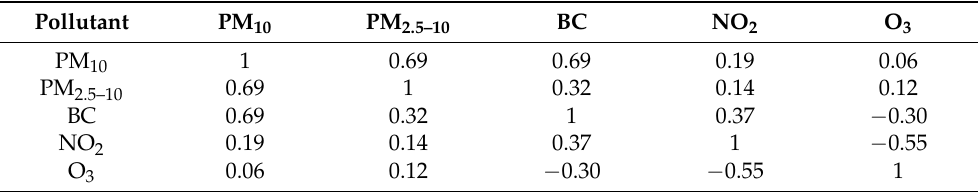
Table A6. Correlation matrix with R-values (Pearson correlation coefficients) between the different air pollutants measured in Stockholm during autumn time (September, October and November) during the period from 2000 to